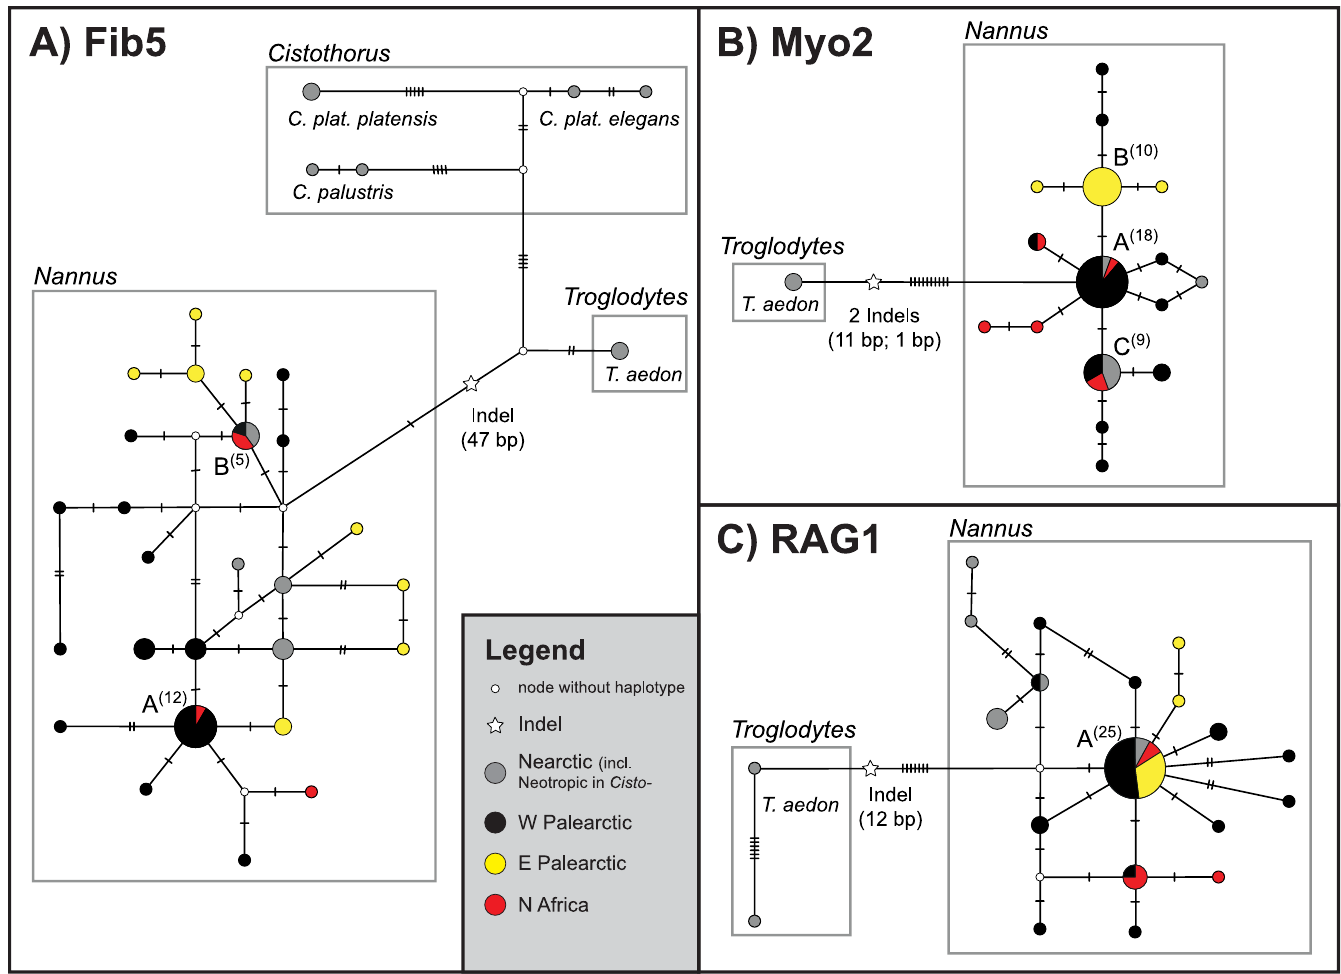
Fig 4. Allelic haplotype networks for three nuclear markers of Nannus spp. samples with troglodytes aedon as outgroup. A: Fib5 , including Cistothorus palustris and C . platensis as outgroups (n = 31); B: Myo2 (n = 27); C: RAG1 (n = 26). Circles scaled to sample size (stated in parentheses for named allelic haplotypes); substitution distances not to